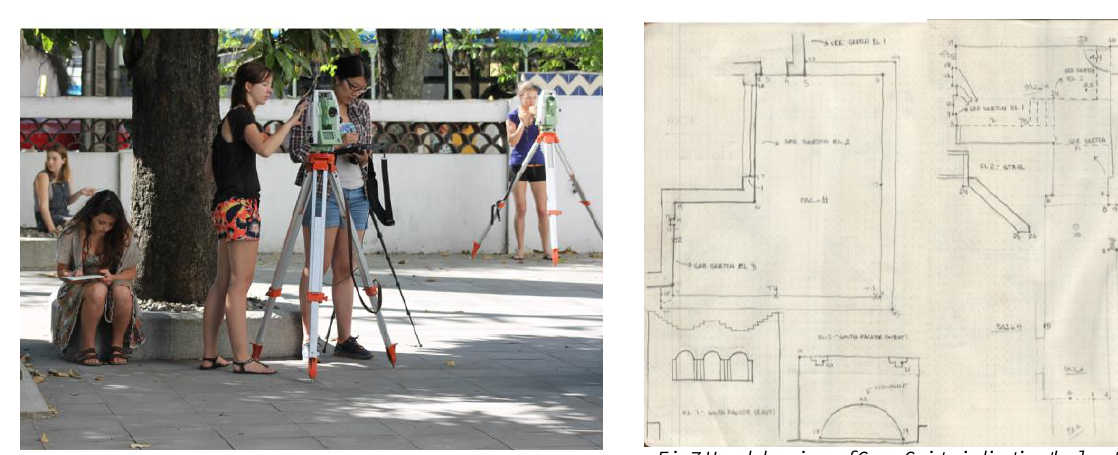
Fig.5 Surveying phase working with the surveyed targets distributed outside the house. Photo’s author: Mario Santana Quintero.